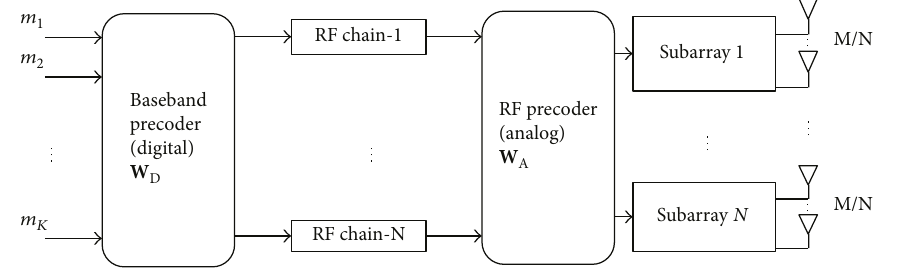
Figure 1: Block diagram of the hybrid precoder structure.